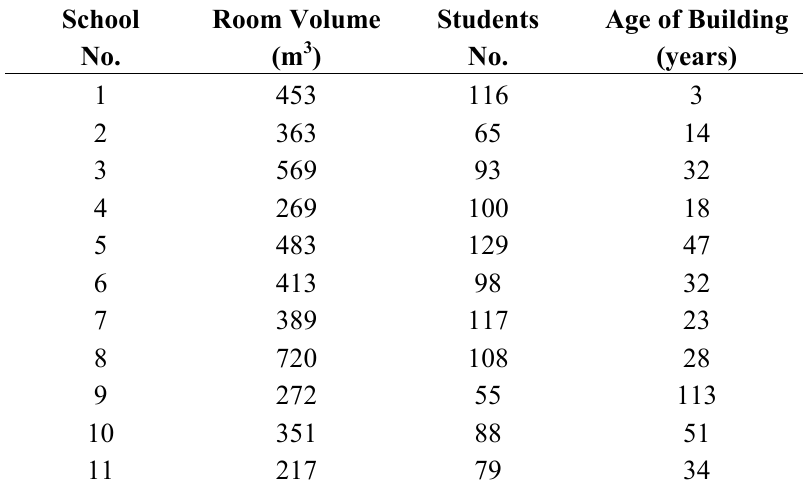
Table 3. School characteristics used for regression